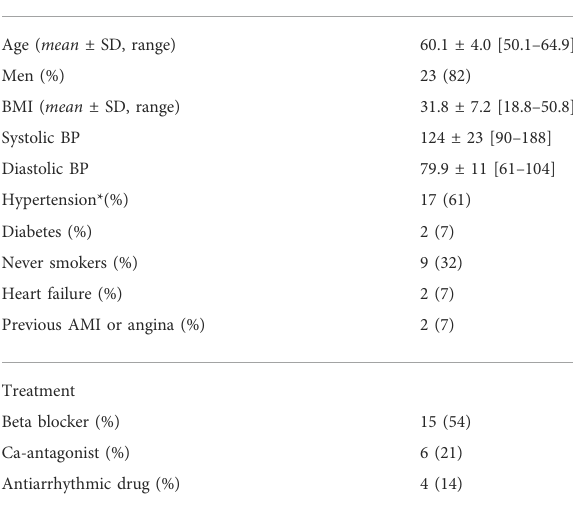
TABLE 1 Clinical characteristics of